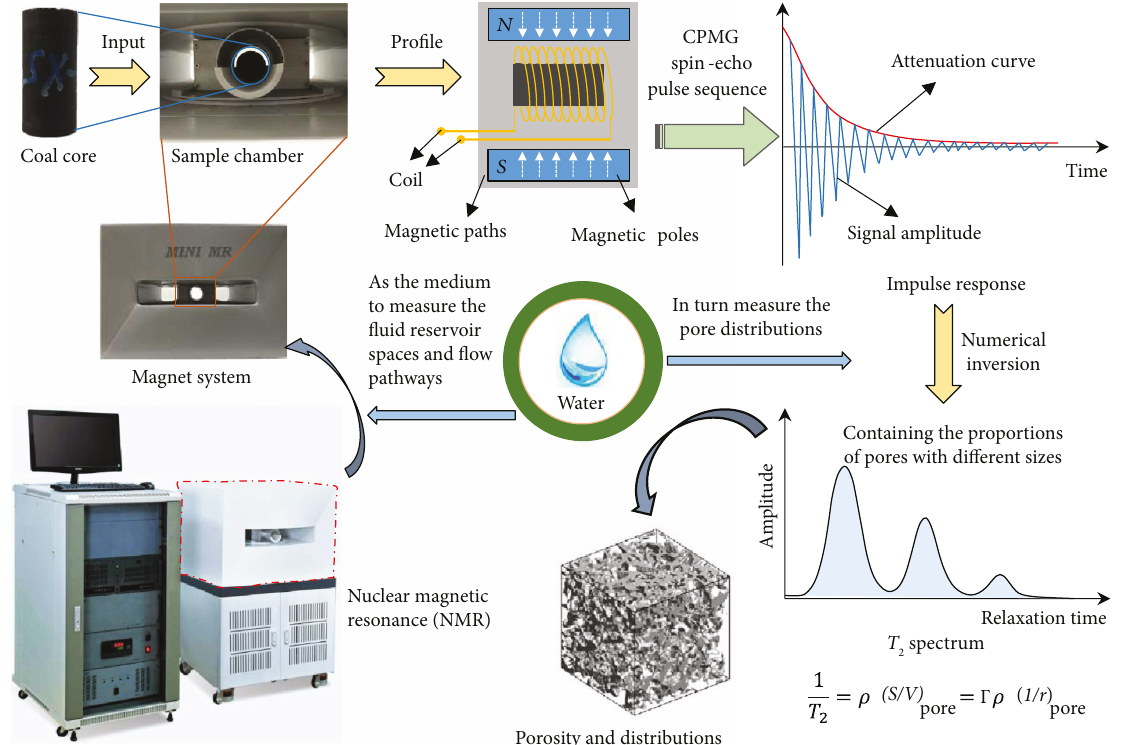
Figure 1: The measurement principle and process of